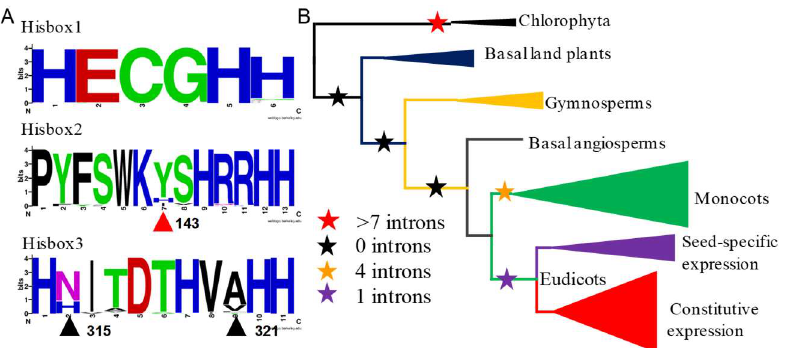
Figure 3. The sequences of Hisboxes and the ancestral states of intron numbers in FAD2 genes. ( A ) The three histidine boxes in FAD2s in plants. The site 143 in GmaFAD2-1 was marked with a red triangle in Hisbox2, and the sites 315 and 321 were marked in black triangles. ( B ) The ancestral states reconstruction of intron numbers. Different clades of FAD2 genes were represented with triangles according to the Figure 2. The stars in different colors represent the ancestral states of intron numbers.